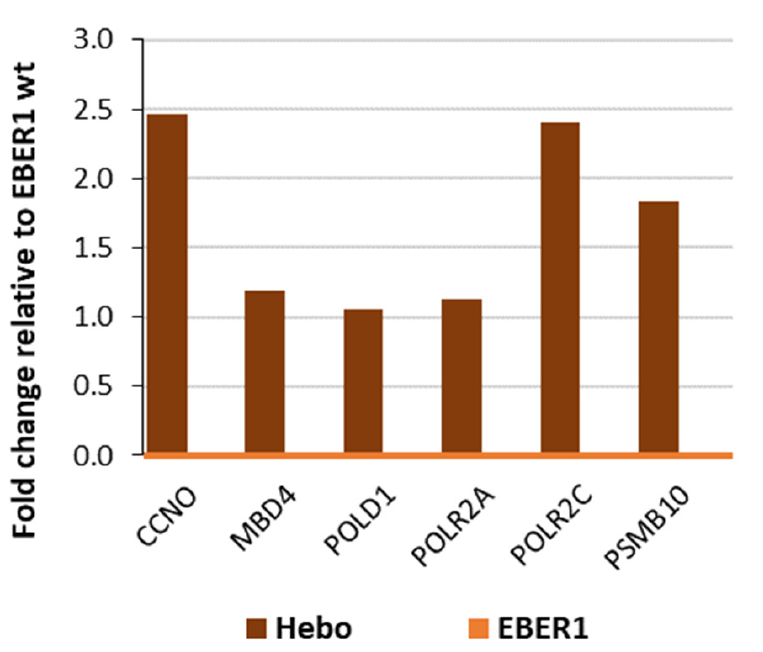
Figure 5. Analysis of genes involved in DNA repair . Total cellular RNA was isolated using TRIzol method, and a total of 5 µ g was reverse transcribed to cDNA. A total of 92 genes associated with DNA repair were quantified using a qPCR-based microarray plate. There was no gene observed to be up to 1-fold decreased. However, pHebo cells showed upregulation of some genes. EBER1 wildtype is set at 0.0 as